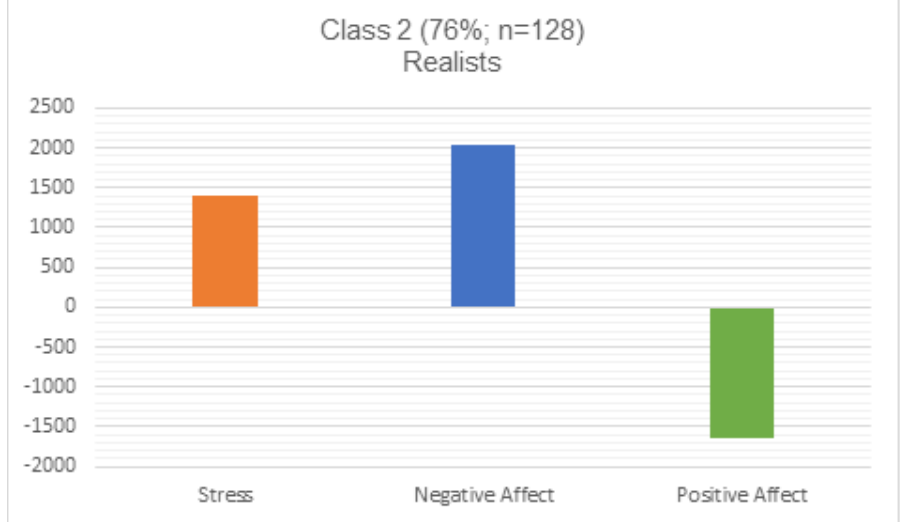
Figure 3. Class 2 relationship with stress, negative and positive affect.